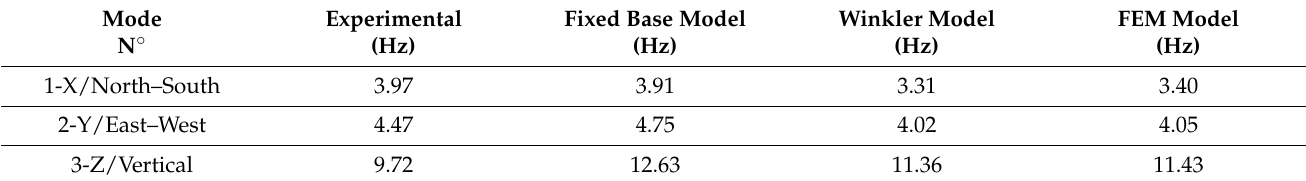
Table 5. Comparison between the main modal frequencies values obtained for San Giuseppe’s bell tower (Aci Castello, Sicily) and different soil models and experimental data.